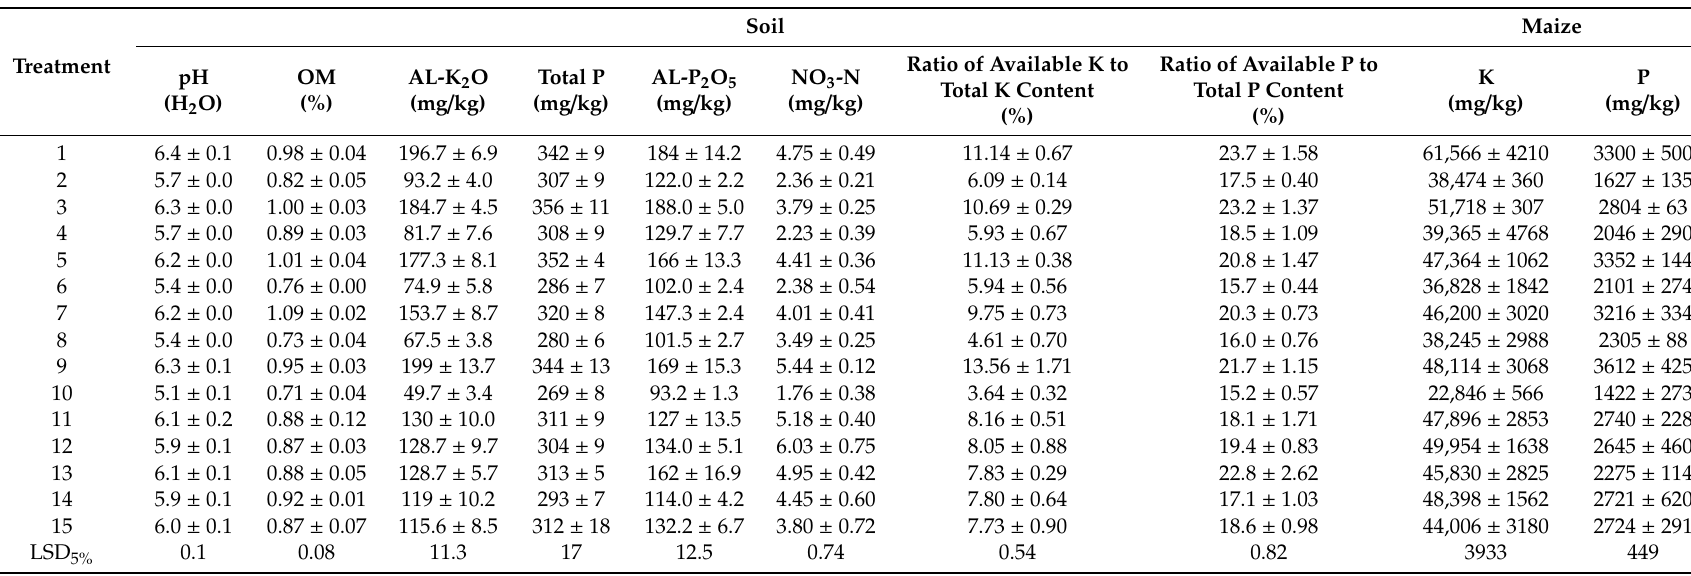
Table 7. Mean values of significant parameters and LSD 5% values from the biochar (BC), compost and plant growth-promoting rhizobacteria (PGPR) combined treatments. Data are mean ± sd of the